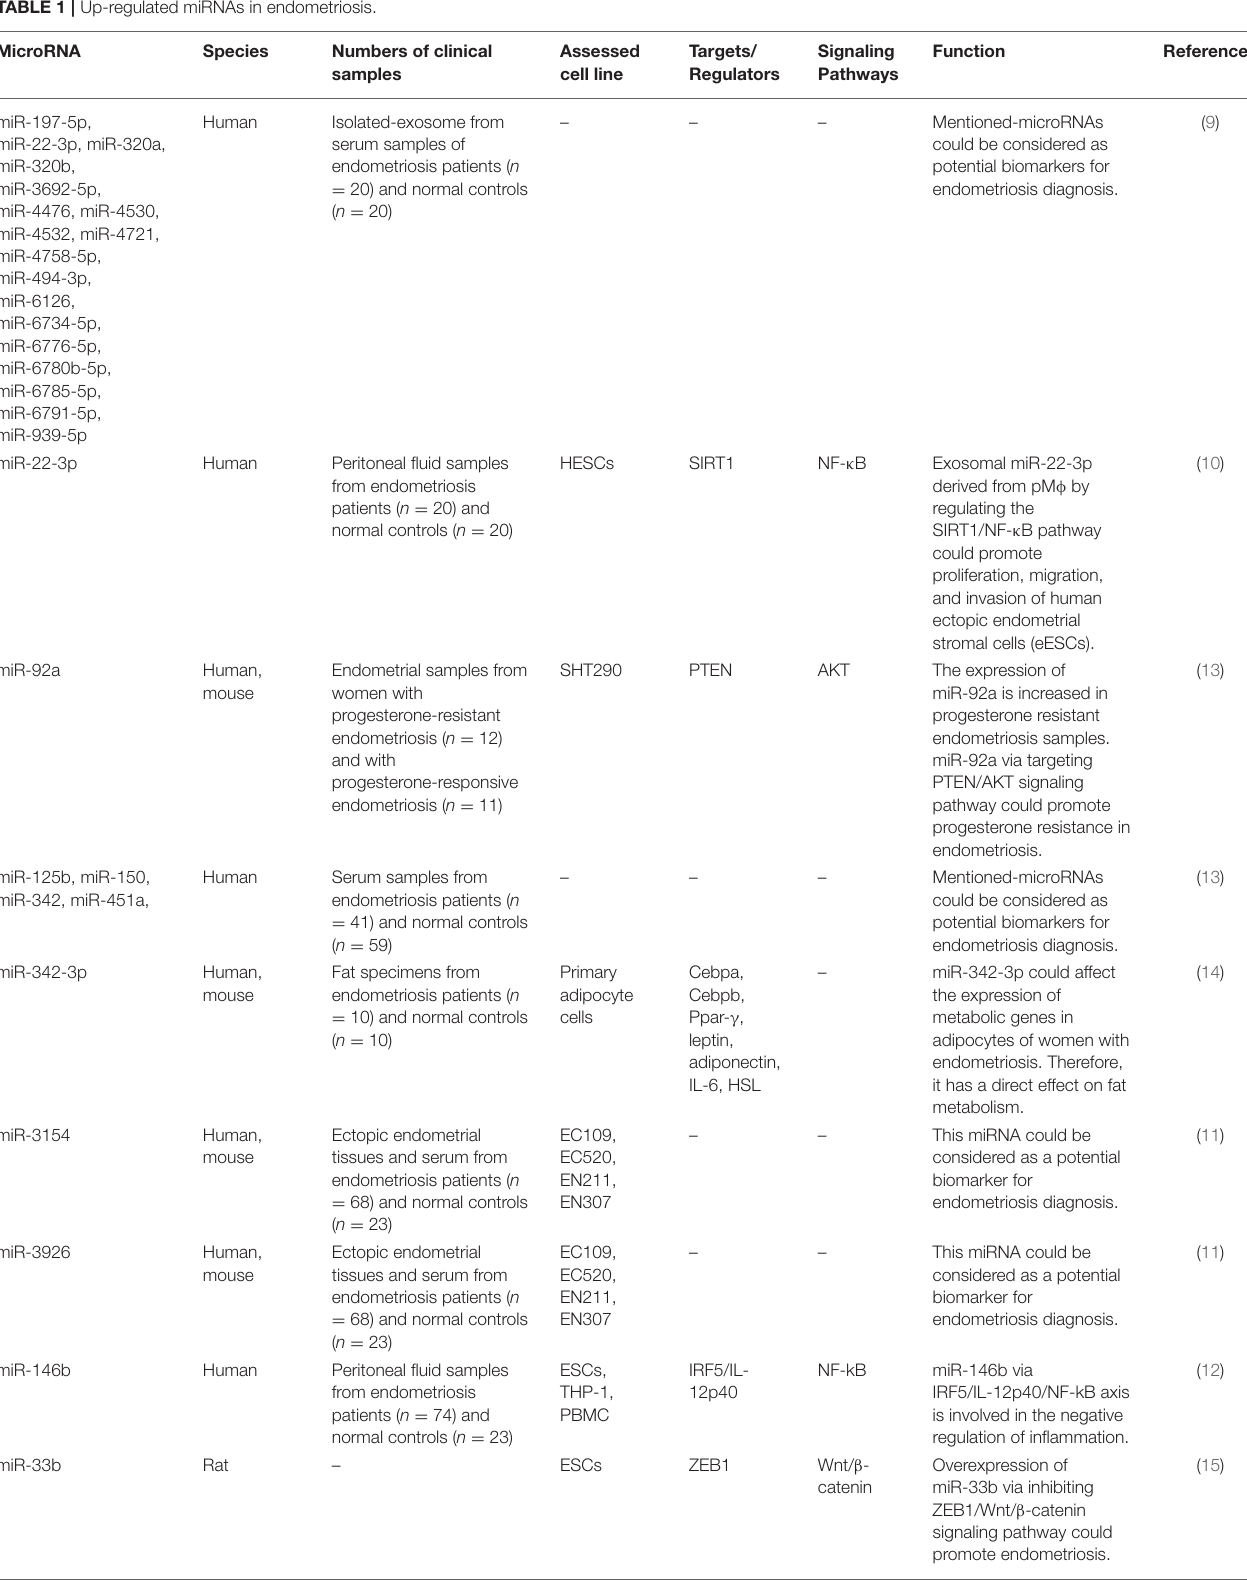
TABLE 1 | Up-regulated miRNAs in